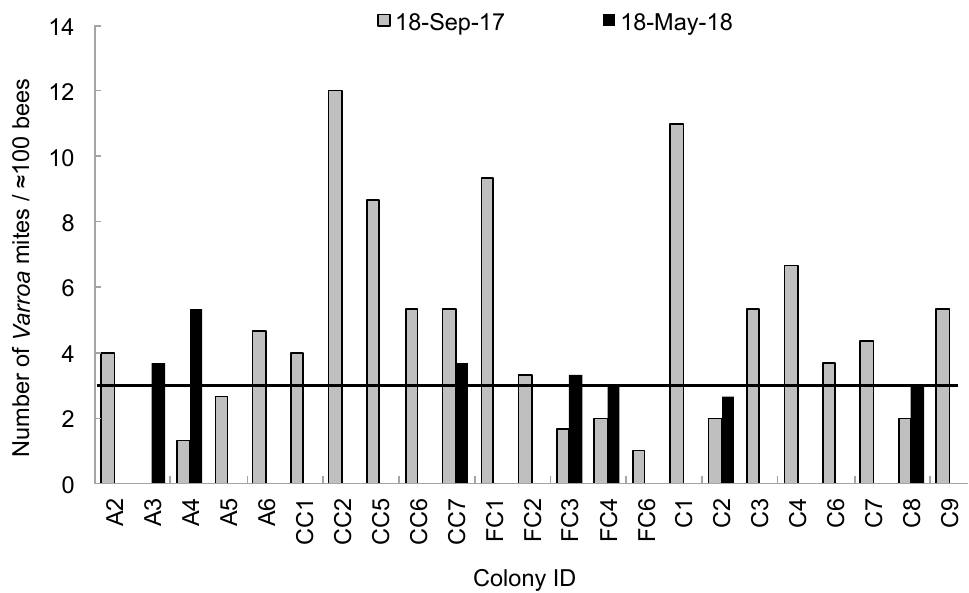
Figure 4. Estimated number of Varroa destructor mites per approximately 100 bees (primary y-axis) obtained from experimental colonies using the powder sugar shake method. The x-axis denotes each colony and the experimental group it belonged to. Experimental treatments include colonies in the amitraz group (A), the chlorothalonil and chlorpyrifos mix group (CC), the tau -fluvalinate and coumaphos mix group (FC) and the control group (C). The first Varroa mite count was done on 18 September 2017 (grey bars) and the second count was done on 18 May 2018 (black bars) for all colonies that were alive on that date. The horizontal black line indicates the threshold of three mites per approximately 100 bees (i.e., 3% infestation level) above which it is typically recommended to perform some type of Varroa control.